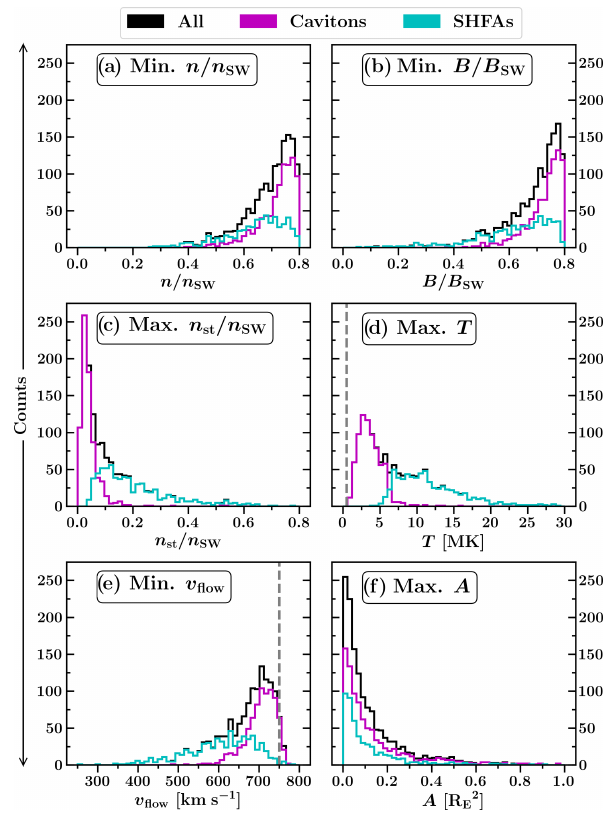
Figure 2. Histograms visualising the distributions of selected quan- tities from Table 1. The grey dashed lines in panels (d) and (e) rep- resent ambient solar wind values. Panels (d) and (f) contain outliers beyond 30MK and 1R E 2 which have been excluded for